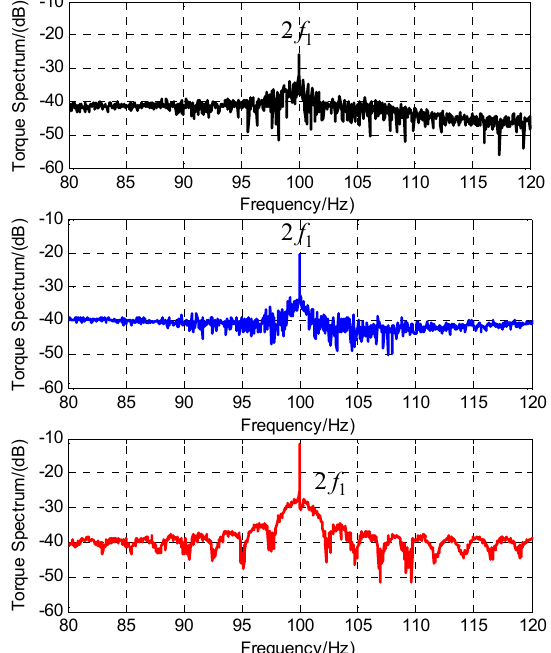
= 0.1 Ω in the induction motor. Energies 2020 , 13 , x FOR PEER REVIEW f